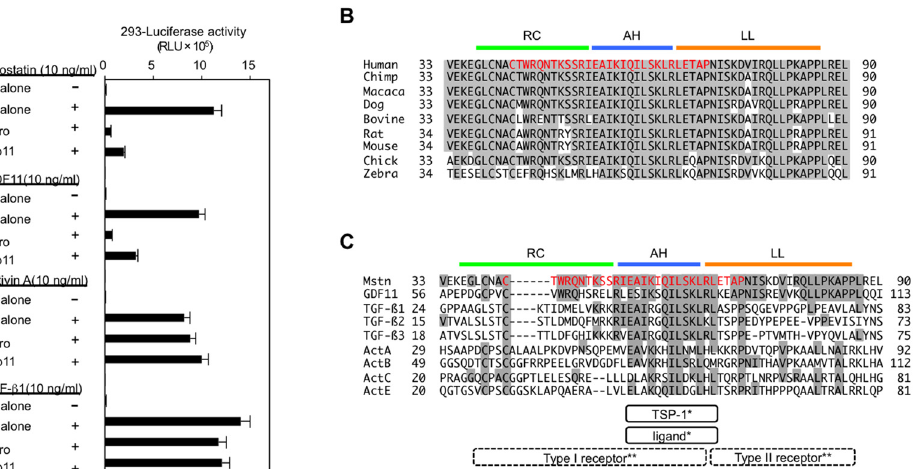
Fig 2. The identified inhibitory core of the myostatin prodomain specifically suppresses myostatin and its analog, GDF11, and includes an AH that is evolutionarily conserved among several other TGF- β family members. ( A ) The full-length myostatin prodomain (f-Pro) and its inhibitory core (Pro11) inhibited the transcriptional activities of myostatin and GDF11, but not of TGF- β 1 or activin A, in HEK293 cells. ( B, C ) Sequence alignment of the prodomains of myostatin in nine species ( B ) and nine TGF- β family members ( C ). Red indicates the identified inhibitory core of the myostatin prodomain, consisting of 29 amino acids. The AH structure (blue) of the TGF- β 1 prodomain has been shown to bind to both its ligand and TSP-1 * [6,18]. Crystallographic analyses of TGF- β 1 and its receptors have predicted that the random coiled structure (RC, green) and the AH are located closely to its type I receptor, whereas the latency lasso structure (LL, brown) is located close to its type II receptor **